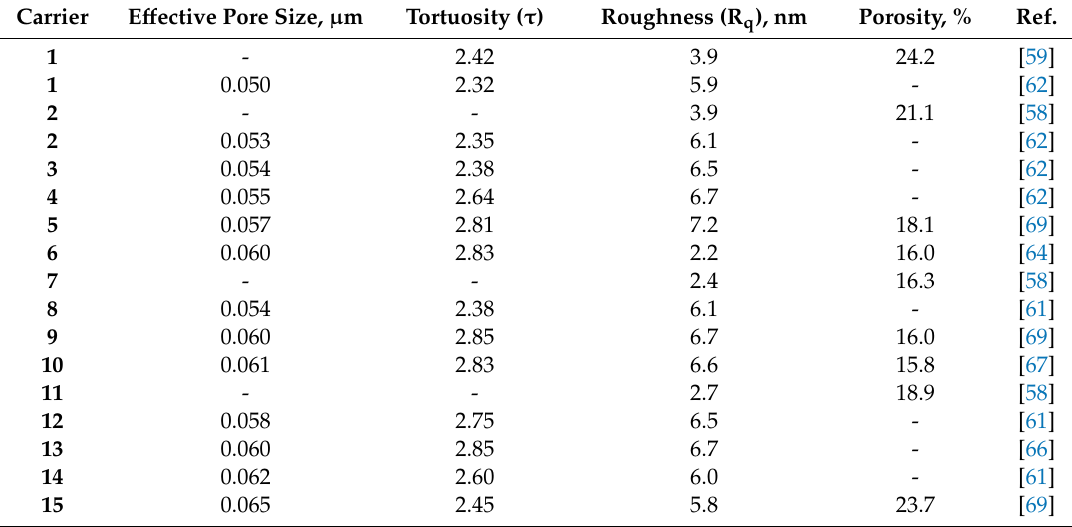
Table 14. Surface parameters of polymeric membranes with alkyl derivatives as carriers. Carrier